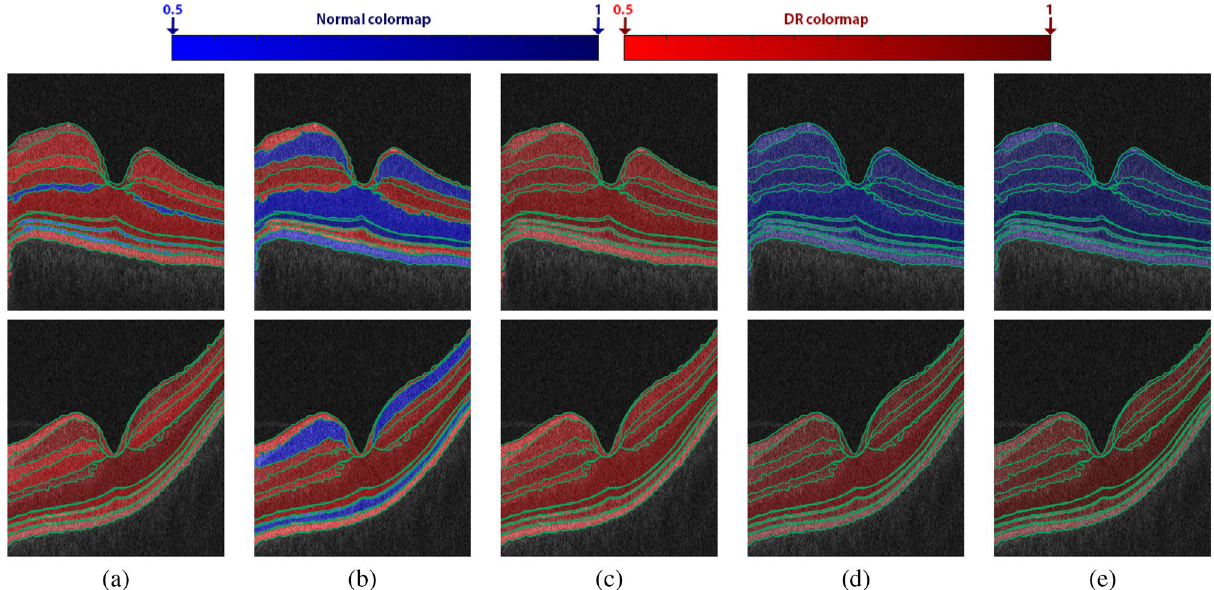
Figure 11. Illustrative color-coded map examples of all retinal layers’ classification for a healthy retina (upper row) and a DR case (lower row) for individual markers: ( a ) Gibbs energy, ( b ) thickness, ( c ) tortuosity, ( d ) reflectivity, and ( e ) their fusion. The range of the color maps consists of 100 different colors for both normal (50 blue) and DR (50 red) classes to visually represent the probability of the classification from 0.5 to 1 with 0.1